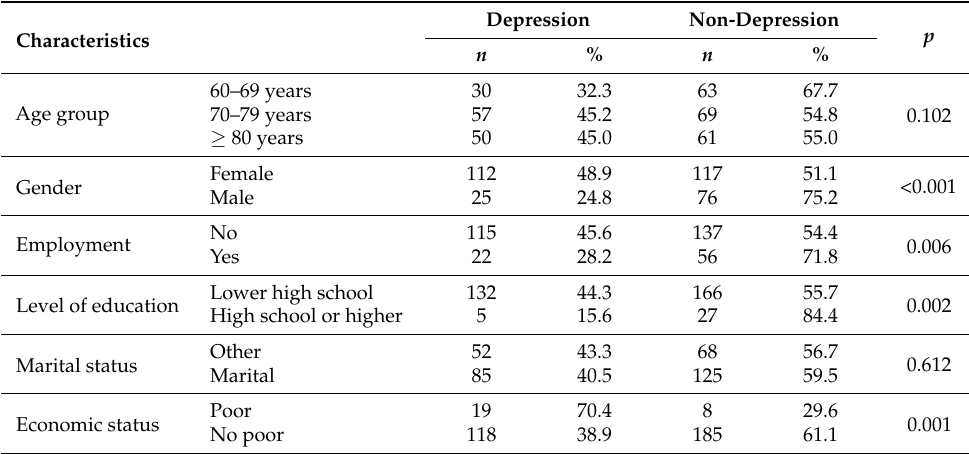
Table 6. The relationship between the general characteristics and